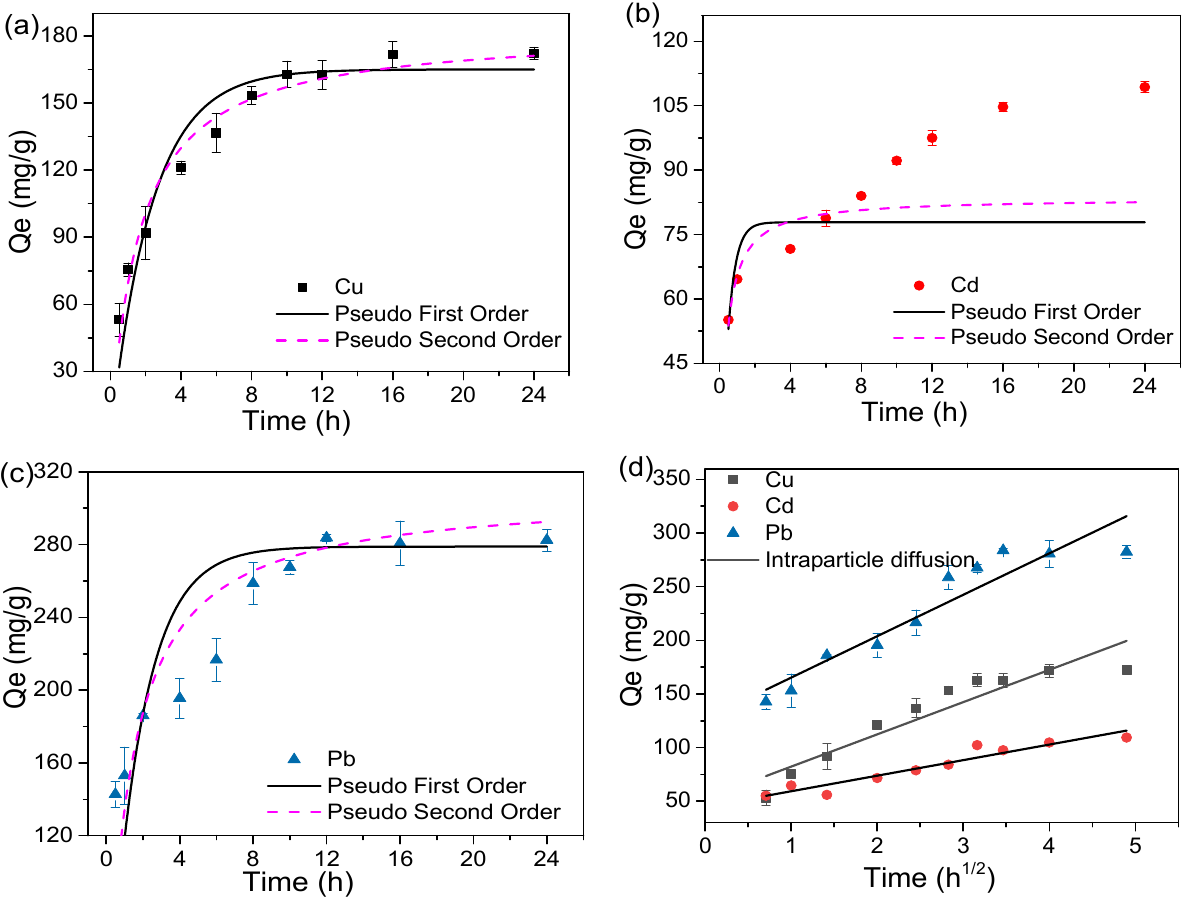
Figure 4. Kinetics of 15%Mg-BC for adsorbing Cu(II) ( a ), Cd(II) ( b ), Pb(II) ( c ), and intraparticle diffusion ( d